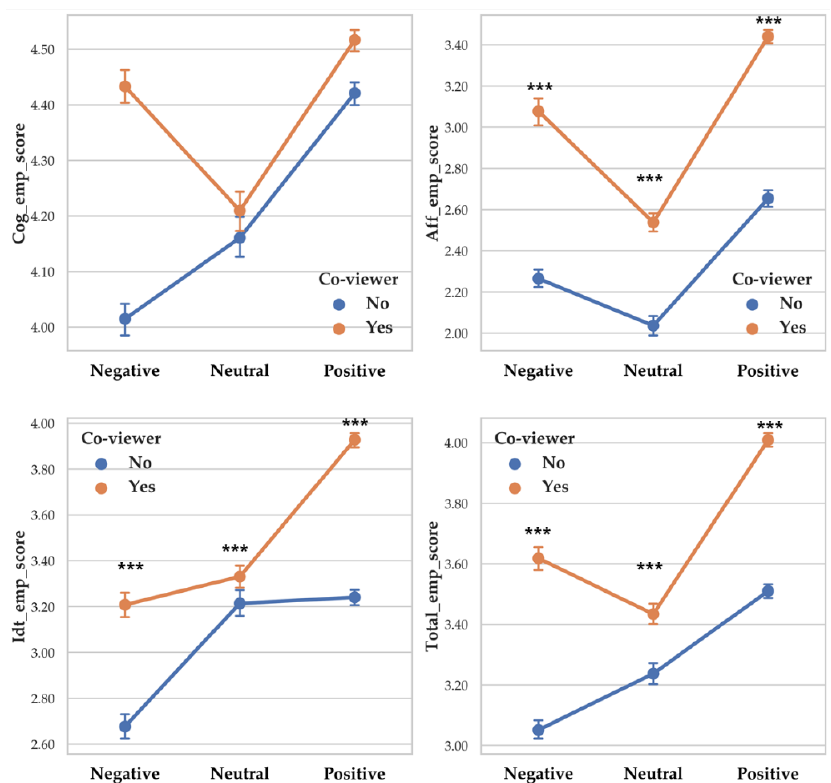
Figure 12. Point graph of self-report empathy depending on co-viewer condition and valence levels. Point means mean of vagal responses. ‘Co-viewer no’ means participants without co-viewer. ‘Co-viewer yes ‘means participants with co-viewer. Asterisk means significant empathy score difference according to co-viewer condition. (***: p < 0.001).